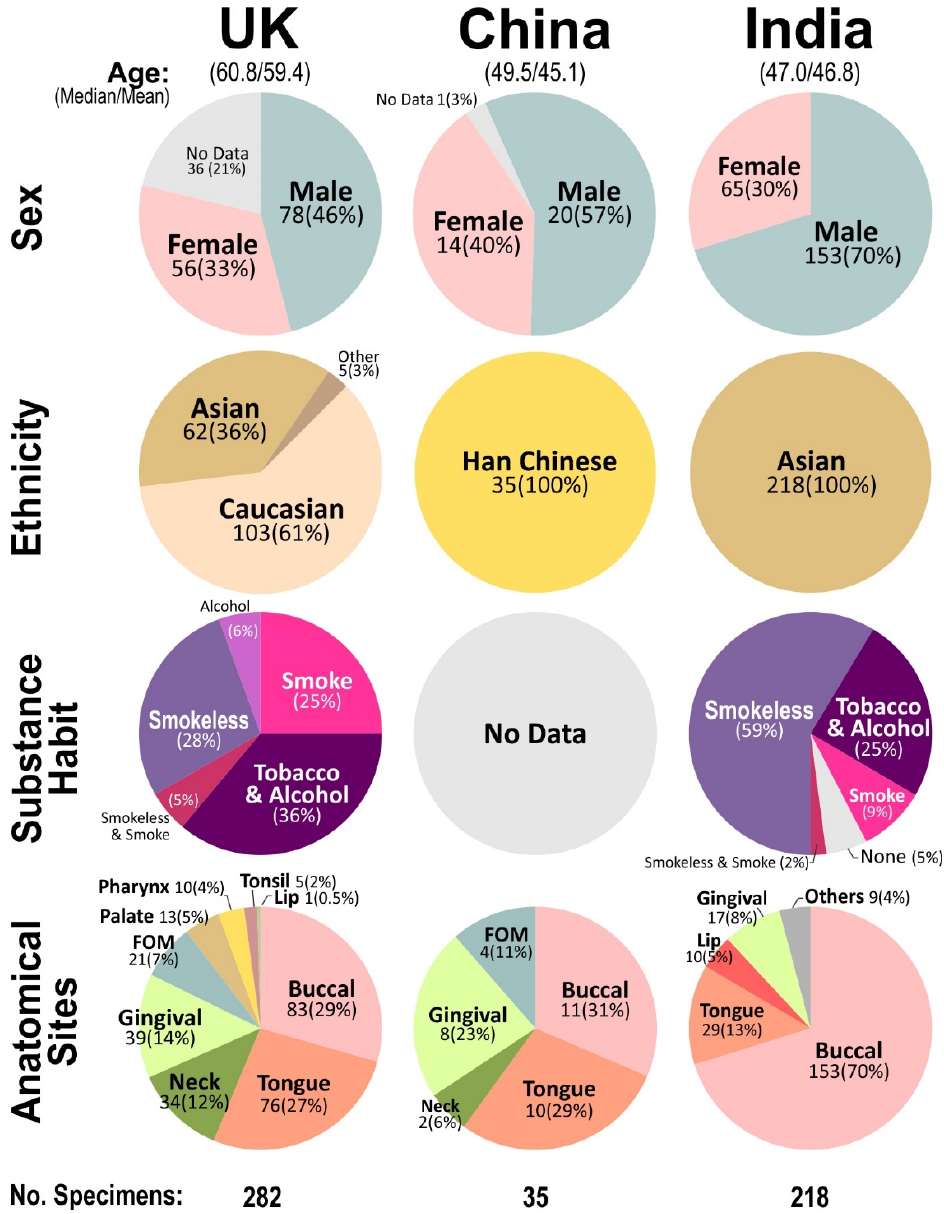
Figure 1. Summary of patient demographic data (age, sex, ethnicity, substance use habits and tissue anatomical sites) associated with all tissue samples used in this study from UK, China and India, respectively. The number of samples are indicated within the pie-chart with % in parenthesis under each data labels. In the UK cohort, each patient contributed either single or multiple samples (paired margins, core and neck metastasis), hence the total number of UK patients were 170 contributing 282 specimens. In China and India cohorts, each patient provided only a single tissue specimen.